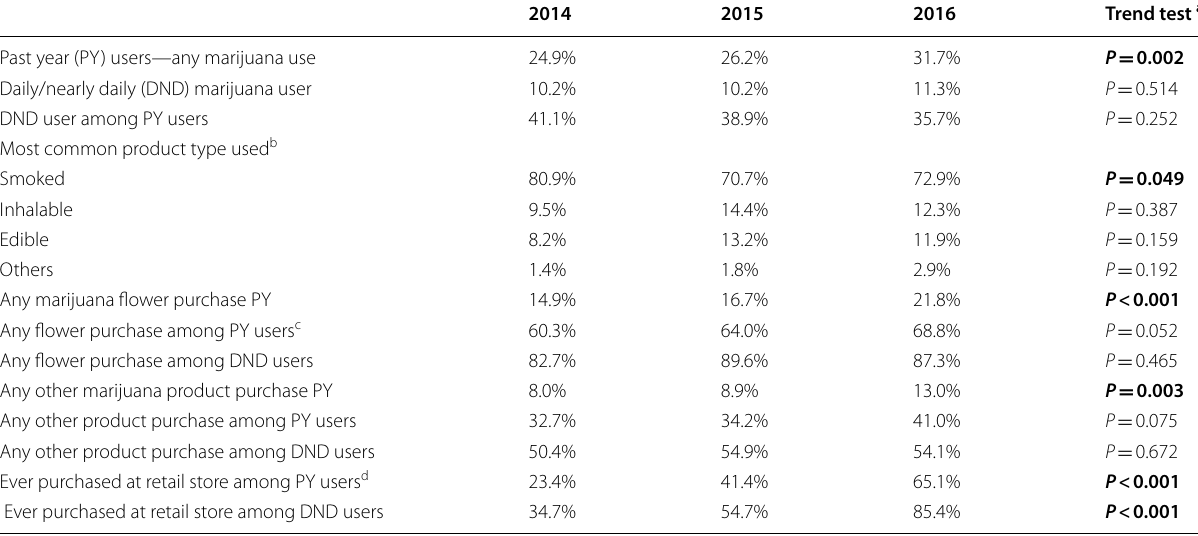
Table 1 Trends in marijuana use and purchasing for Washington state from 2014 to